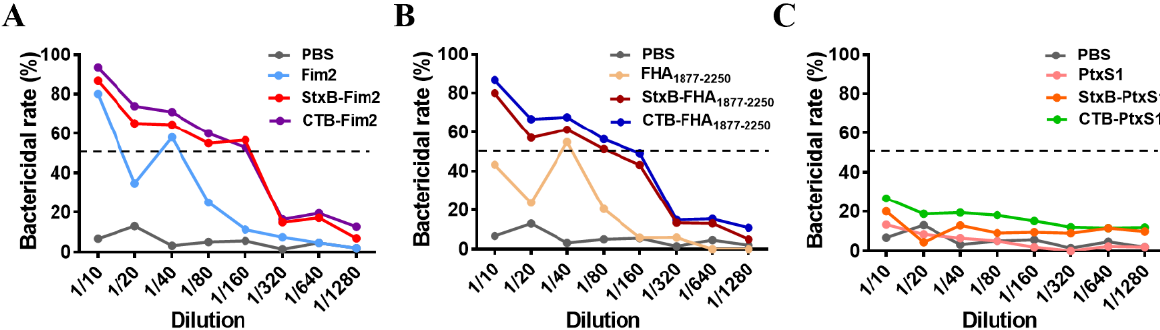
Figure 3. Evaluation of mice serum bactericidal activity. Different dilutions of serum from immunized mice (with inactived complement), B. pertussis suspension, and complement were co-incubated and cultured to enumerated colonies. The in vitro serum bactericidal activity was then calculated via comparison with the blank control group (without serum). ( A ) In vitro bactericidal efficiency of different dilutions of serum from mice in the PBS, Fim2, StxB-Fim2, and CTB-Fim2 groups. ( B ) In vitro bactericidal efficiency of different dilutions of serum from mice in the PBS, FHA 1877–2250 , StxB-FHA 1877–2250 , and CTB-FHA 1877–2250 groups. ( C ) In vitro bactericidal efficiency of different dilutions of serum from mice in the PBS, PtxS1, StxB-PtxS1, and CTB-PtxS1 groups. The dotted lines represent the serum bactericidal rate of